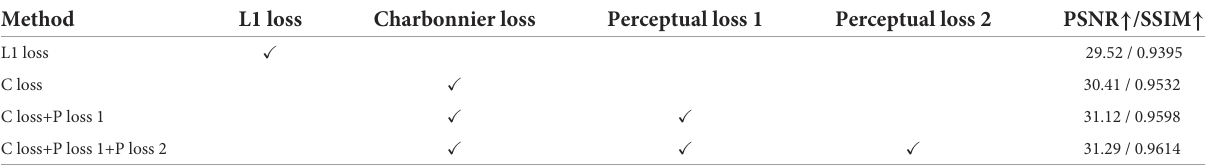
TABLE 3 Scores of STTTN under different loss function